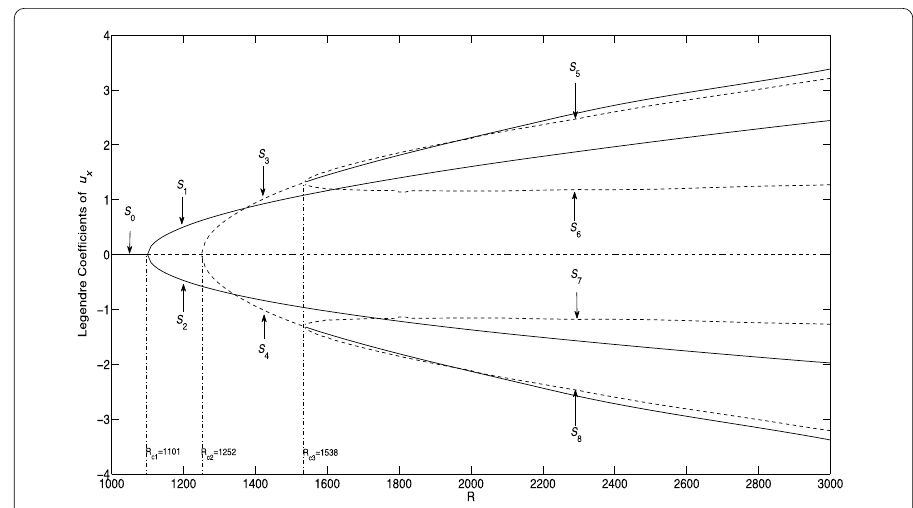
Figure 4 Bifurcation diagram where the value of the combination of coefficients a 03 + a 13 of the Legendre expansion of the field u x as a function of the Rayleigh number is presented. Solutions S are calculated